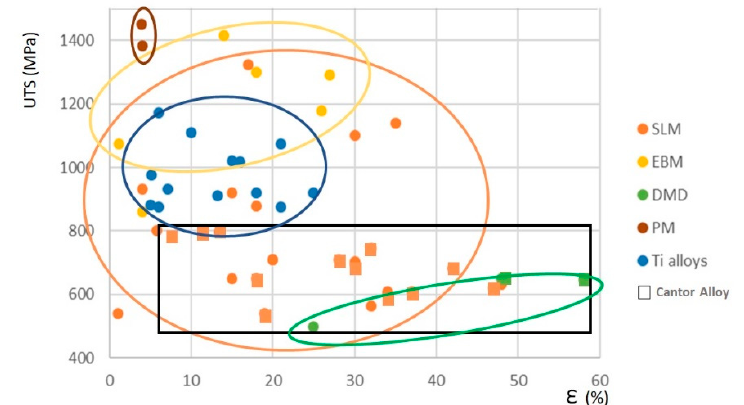
Figure 8. Tensile features of selected HEAs obtained by different additive manufacturing routes, after [28–30,33,35,38,40,44,45,49,52,56,70–79]. In the black square and also highlighted with square dots are confined most of the plain CAs.